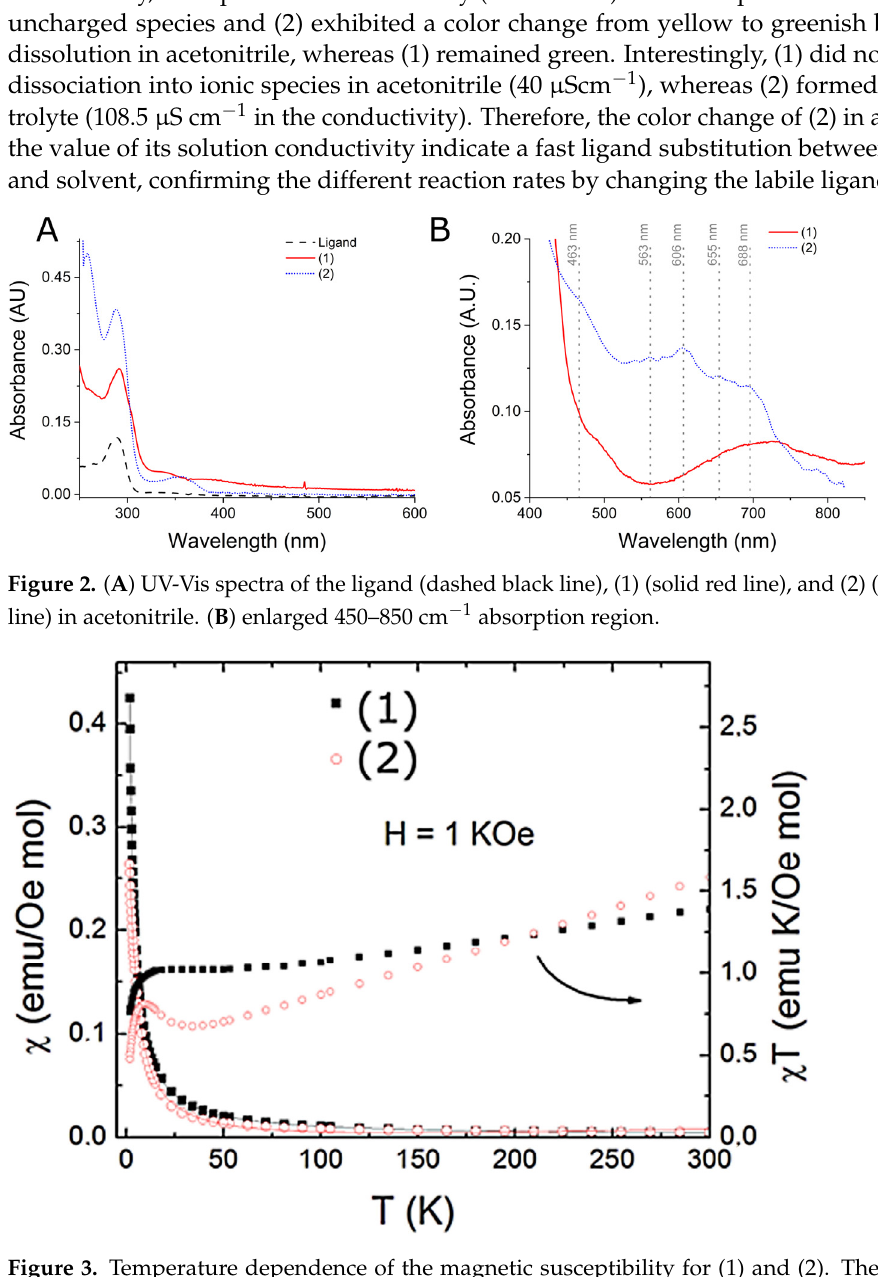
Figure 3. Temperature dependence of the magnetic susceptibility for (1) and (2). The solid lines represent the fits based on Equation (1).